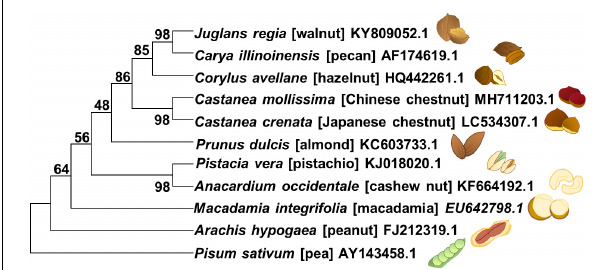
FIGURE 2 | Phylogenetic relationship of ten nut plant species presented in this review. The phylogenetic tree was constructed by MEGA X (Kumar et al., 2018) by using the sequences of ITS (internal transcribed spacer) gene of each species which were retrieved from the NCBI database. P. sativum was considered as an outgroup. The parameters for maximum-likelihood analysis were shown as followed: Kimura 2-parameter model, complete deletion, and bootstrap (1000 replicates). Values presented on the branches demonstrated bootstrap support in